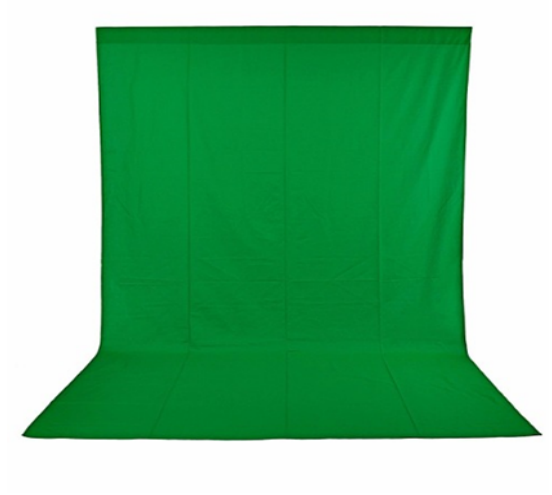
Figure 6. Chroma-key green